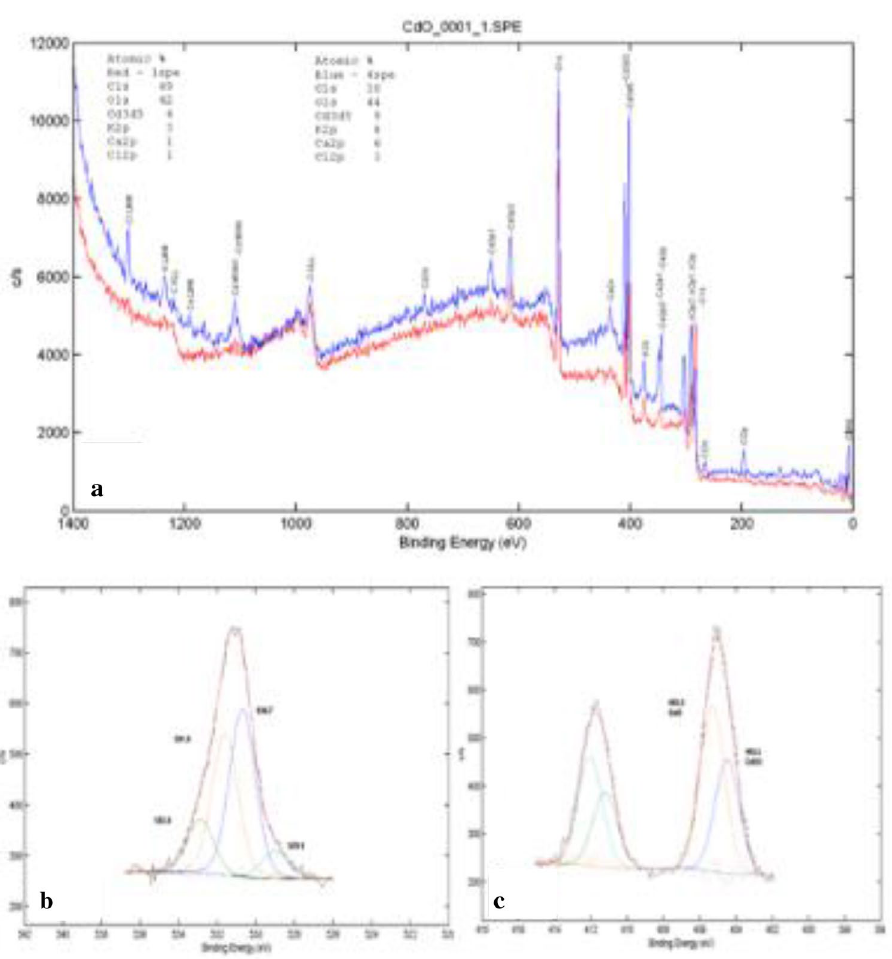
Figure 6. XPS ( a ) wide scan survey of the CdO-containing samples, ( b ) High resolution spectrum denoting the existence of O 2 , and ( c ) High resolution spectrum denoting the presence of Cd 2+ as in